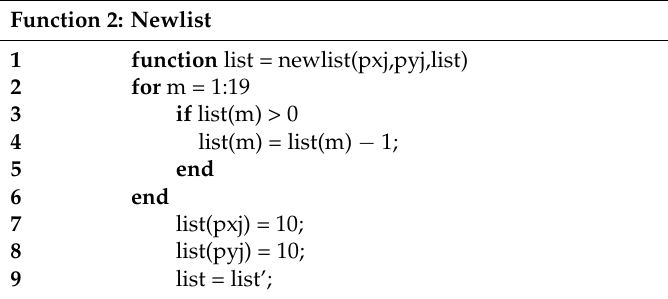
Table A3. List update of tabu algorithm.